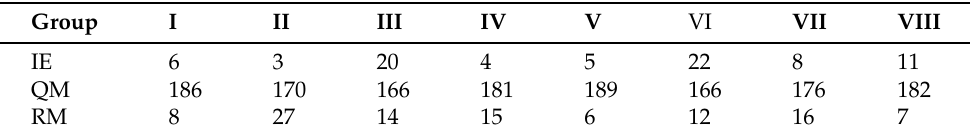
Table 2. Total number of communicated observations in terms of idle epoch (IE), transient (QE), and raw measurements